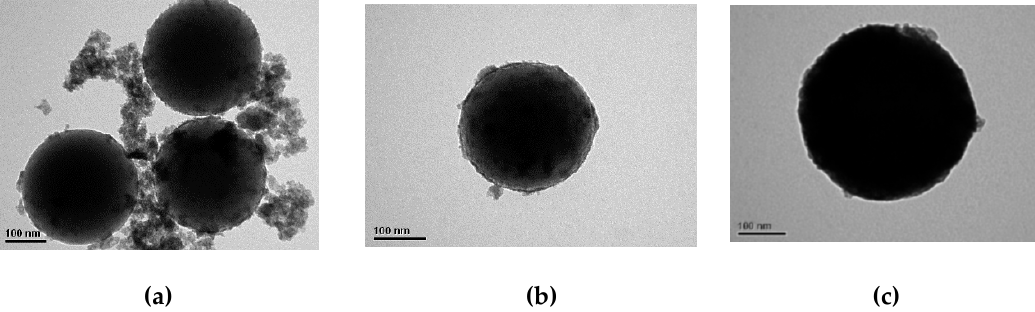
Figure 3. TEM micrographs calcined at 700 ◦ C for ( a ) SiO 2 @ZrO 2 —0.04 M, ( b ) SiO 2 @ ZrO 2 —0.06 M, and ( c ) SiO 2 @ZrO 2 —0.08M.